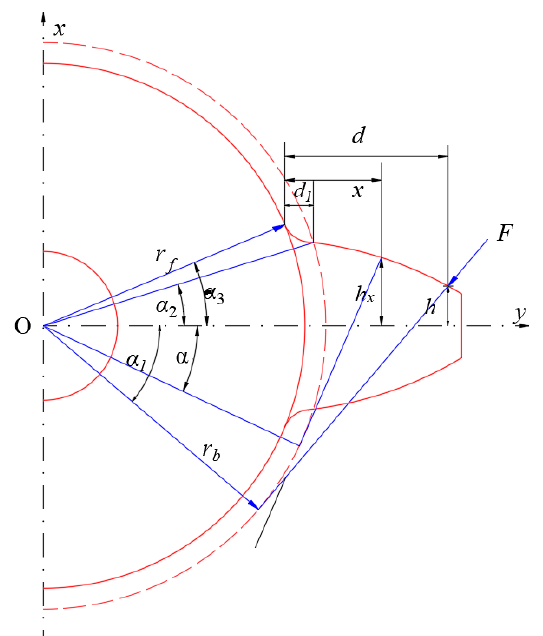
Figure 2. Gear tooth cantilever beam model.